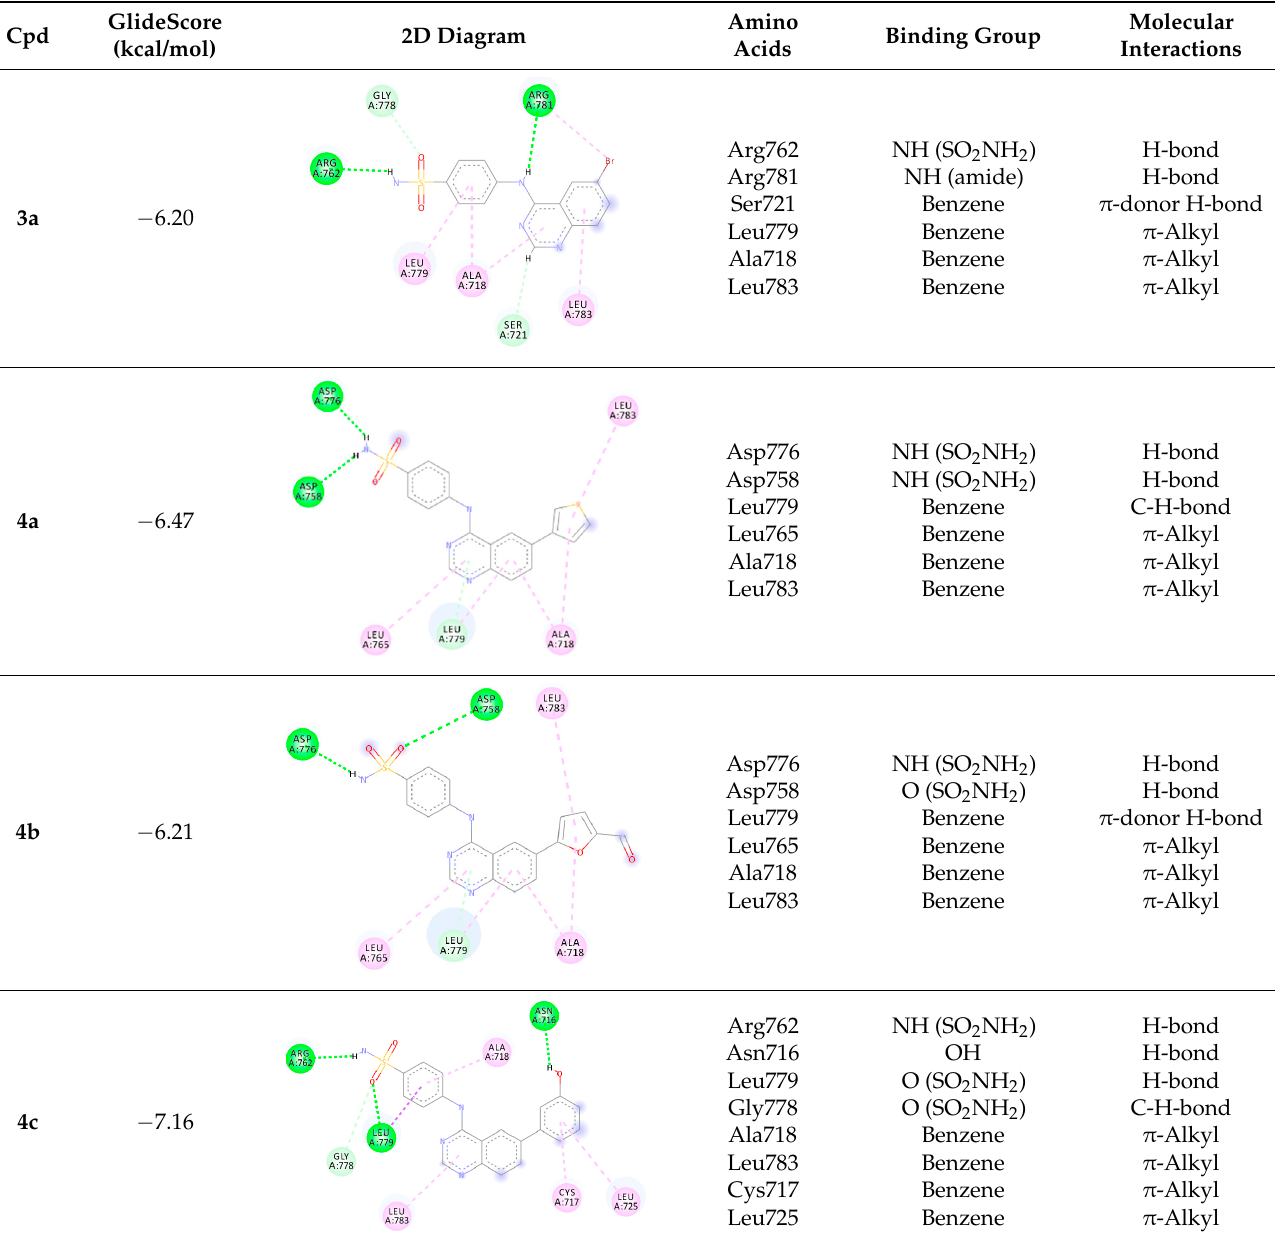
Table 2. Molecular docking study results of the top seven hits generated from the virtual combinatorial library. GlideScore Cpd 2D Diagram Cpd (kcal/mol)